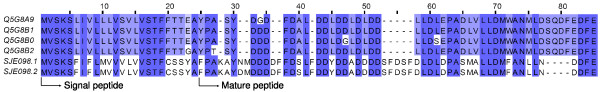
Sequence alignment of anionic peptides. SJEs are clusters from this work. Q5G8B2, Q5G8A9, Q5G8B1, and Q5G8B0 are different anionic peptides from the scorpion Tityus costatus.